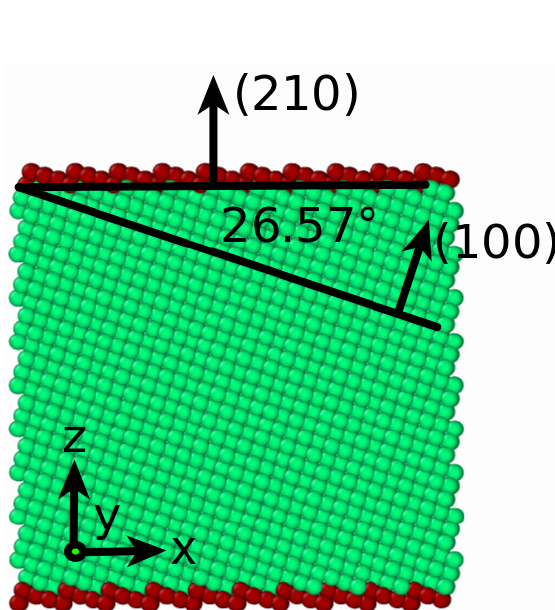
Figure 1. Side view of a bcc sample with a (210) surface. The tilt angle φ towards the (100) plane (Equation (1)) is indicated. Colors denote the local crystal structure. Green, bcc; dark blue, fcc; light blue, hcp; red,